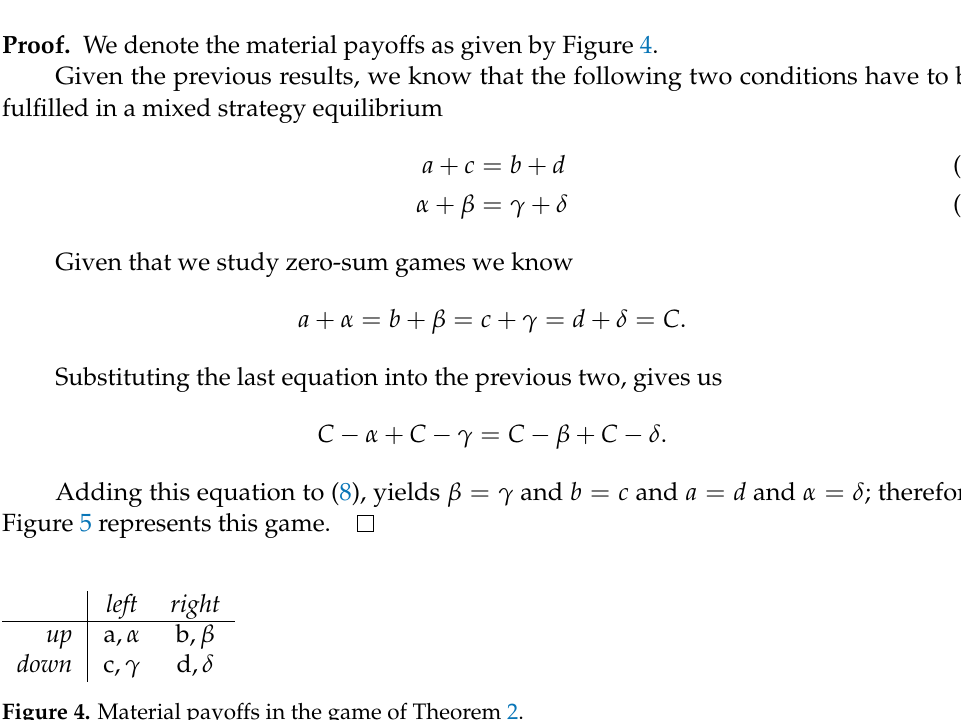
Figure 4. Material payoffs in the game of Theorem 2.